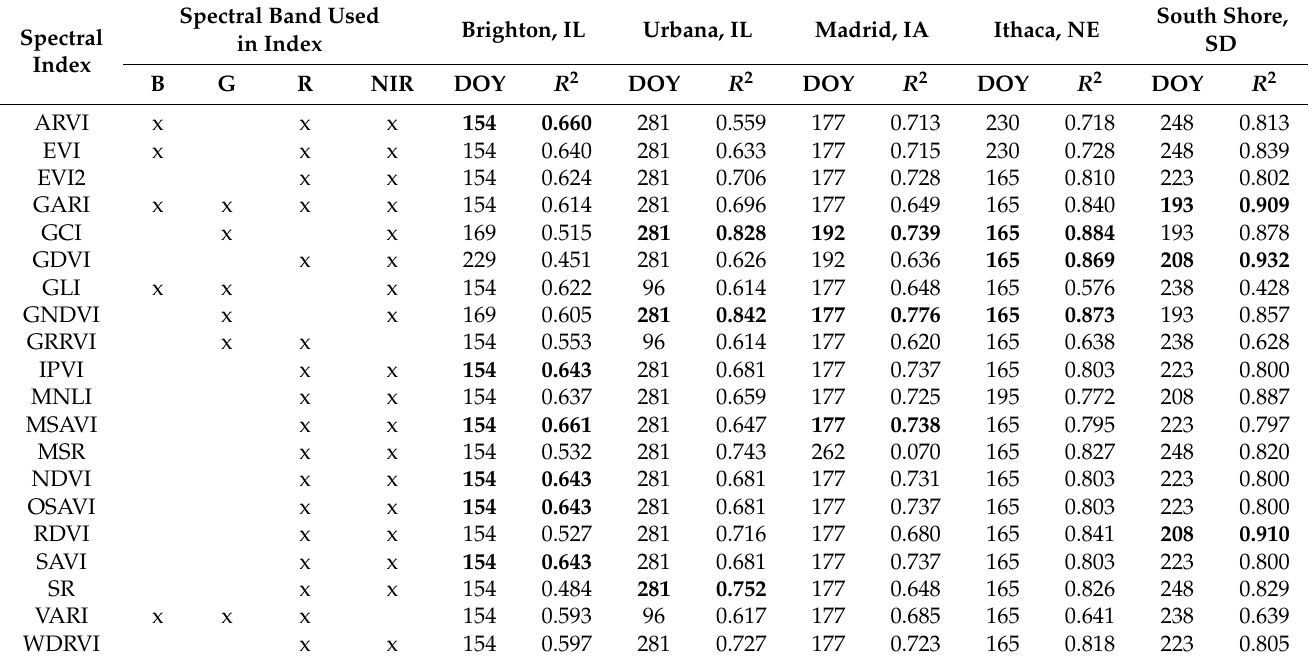
Table 5. Summary of the highest coefficient of determination ( R 2 ) values between spectral vegetation indices and perennial grass dry biomass yields measured at harvest and the corresponding date of image collection for each study site *.